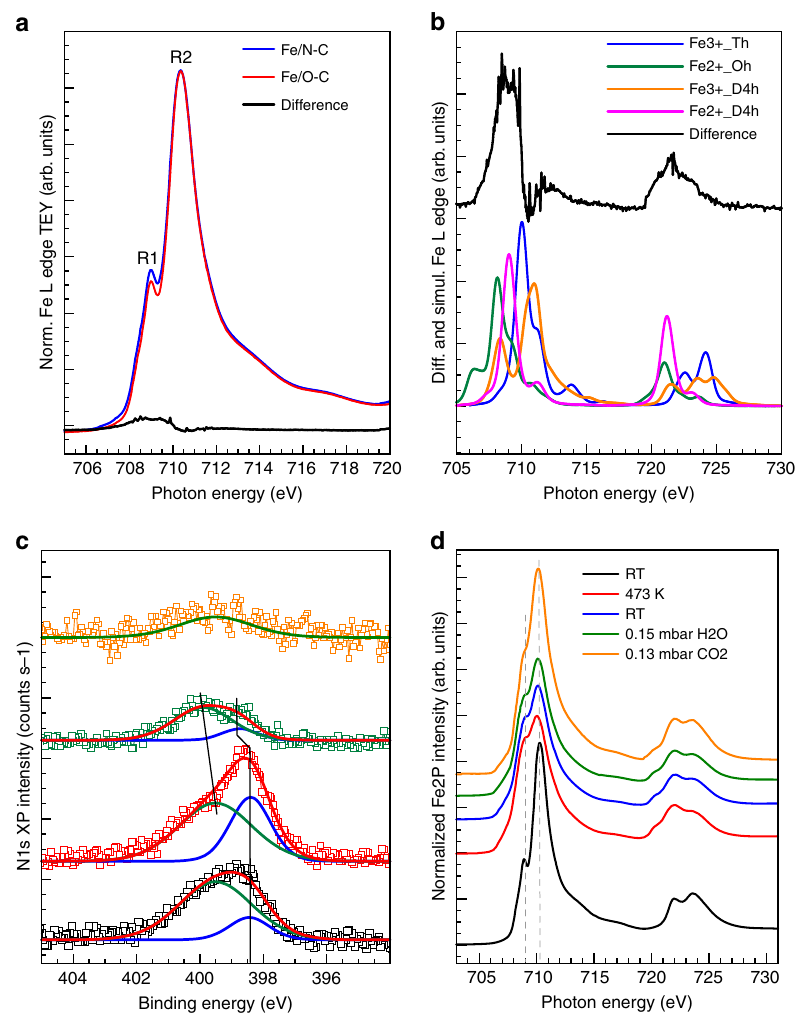
Fig. 4 Surface sensitive XPS and NEXAFS spectra of the Fe/O-C and Fe/N-C samples. a Fe L edge NEXAFS spectrum of Fe/O-C (red line), Fe/N-C (blue line), and residual of the difference between the two spectra (black line); b Difference spectrum (black line) and simulated spectra using the CTM4XAS software 22 using simulation parameter as reported in ref. 23 . c Deconvolved N1s XP spectra (KE = 150 eV) using a peak for pyridine species (N-C) at 398.4 eV and full width at half maximum (FWHM) of 1.4 eV (blue line) and a peak for Fe – N species at 399.6 eV and FWHM of 2.7 eV (green line). d Fe L edge NEXAFS spectra relative to Fe/N-C at: 298 K in UHV (black line); 473 K in UHV (red line); after cooling at 298 K in UHV (blue line); at 298 K in 0.15 mbar H 2 O (green line); at 298 K in 0.13 mbar CO 2 (orange